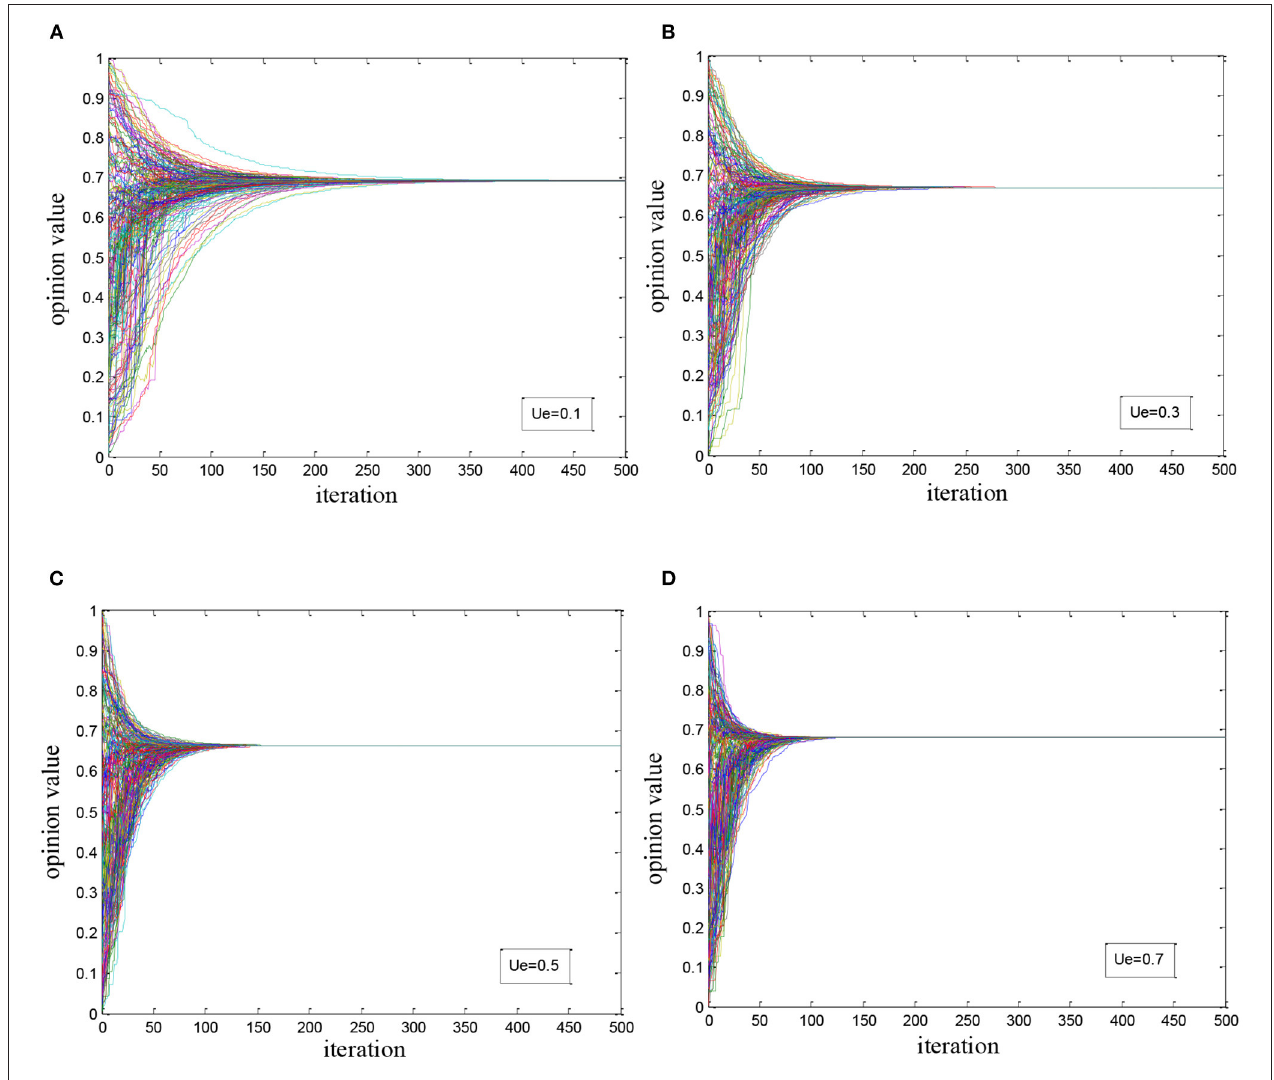
FIGURE 2 | Simulation of health opinion evolution with elites and ordinary users coexisting: (A) u e = 0.1; (B) u e = 0.3; (C) u e =0.5; (D) u e = 0.7.